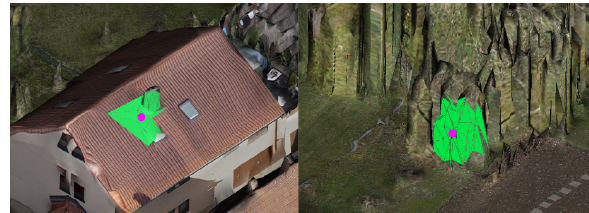
Figure 2. SPNHs (radius 1 . 5 m , green ) and corresponding COGs ( pink ) for which the feature vectors are generated.